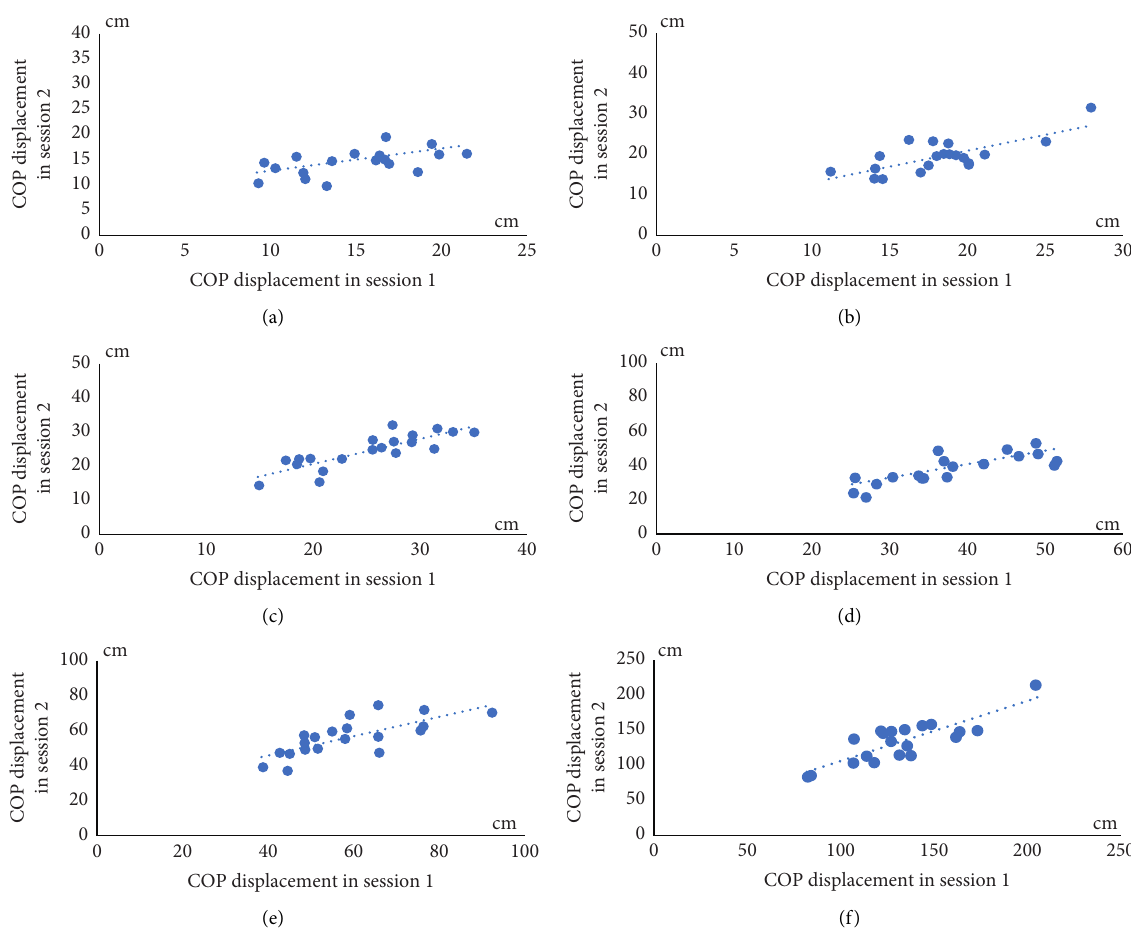
Figure 5: Scatter plots of COP displacements between sessions 1 and 2 from six testing conditions. (a) COP displacements during DLS-SW- EO. (b) COP displacements during DLS-SW-EC. (c) COP displacements during DLS-FT-EO. (d) COP displacements during DLS-FT-EC. (e) COP displacements during SLS-EO. (f) COP displacements during